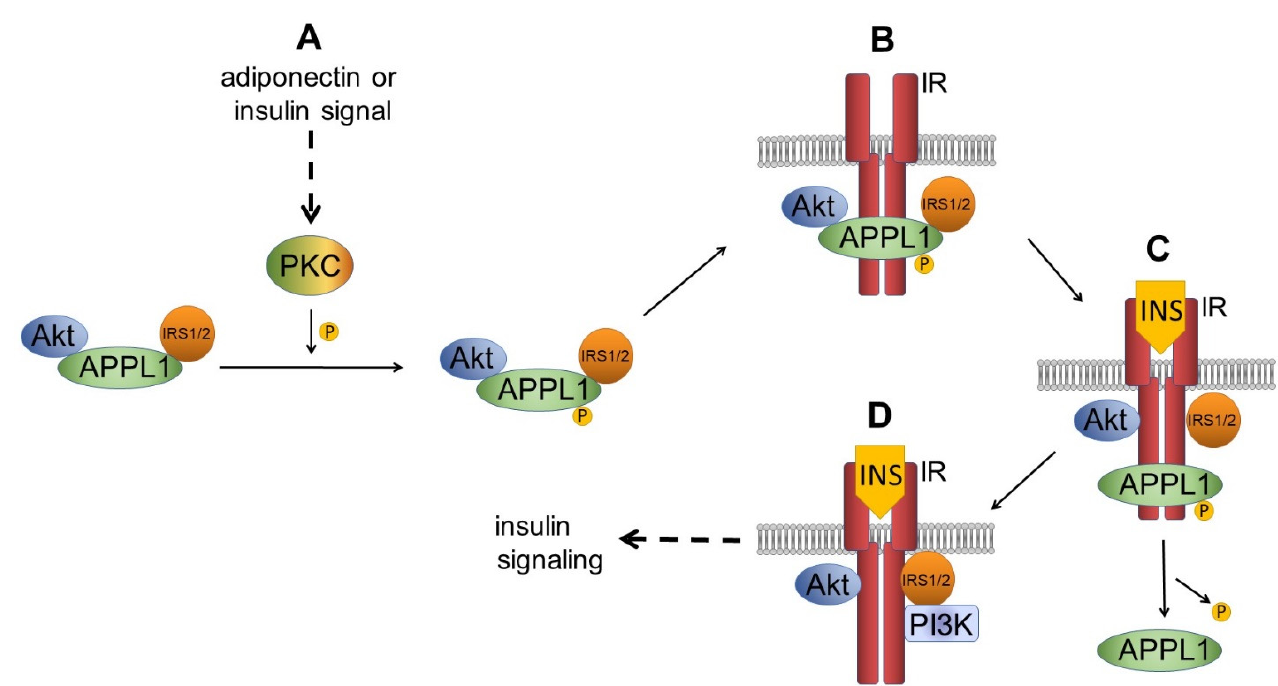
Figure 3. Integration of insulin and adiponectin signaling pathways. ( A ) Upon adiponectin or insulin stimulation, PKC phosphorylates APPL1. This results in insulin receptor 1/2 (IRS1/2) and Akt recruitment, resulting in APPL1/IRS1/2/Akt complex formation. This complex then associates with the insulin receptor (IR). ( B ) After the binding of insulin (INS) to the IR, APPL1 “piggybacks” Akt and IRS1/2 on the IR. ( C ) Dephosphorylated APPL1 dissociates from the complex. ( D ) IRS1/2 phosphorylates phosphatidylinositol-3 kinase (PI3K), and PI3K phosphorylates Akt, which activates its further substrates in the insulin signaling pathway.